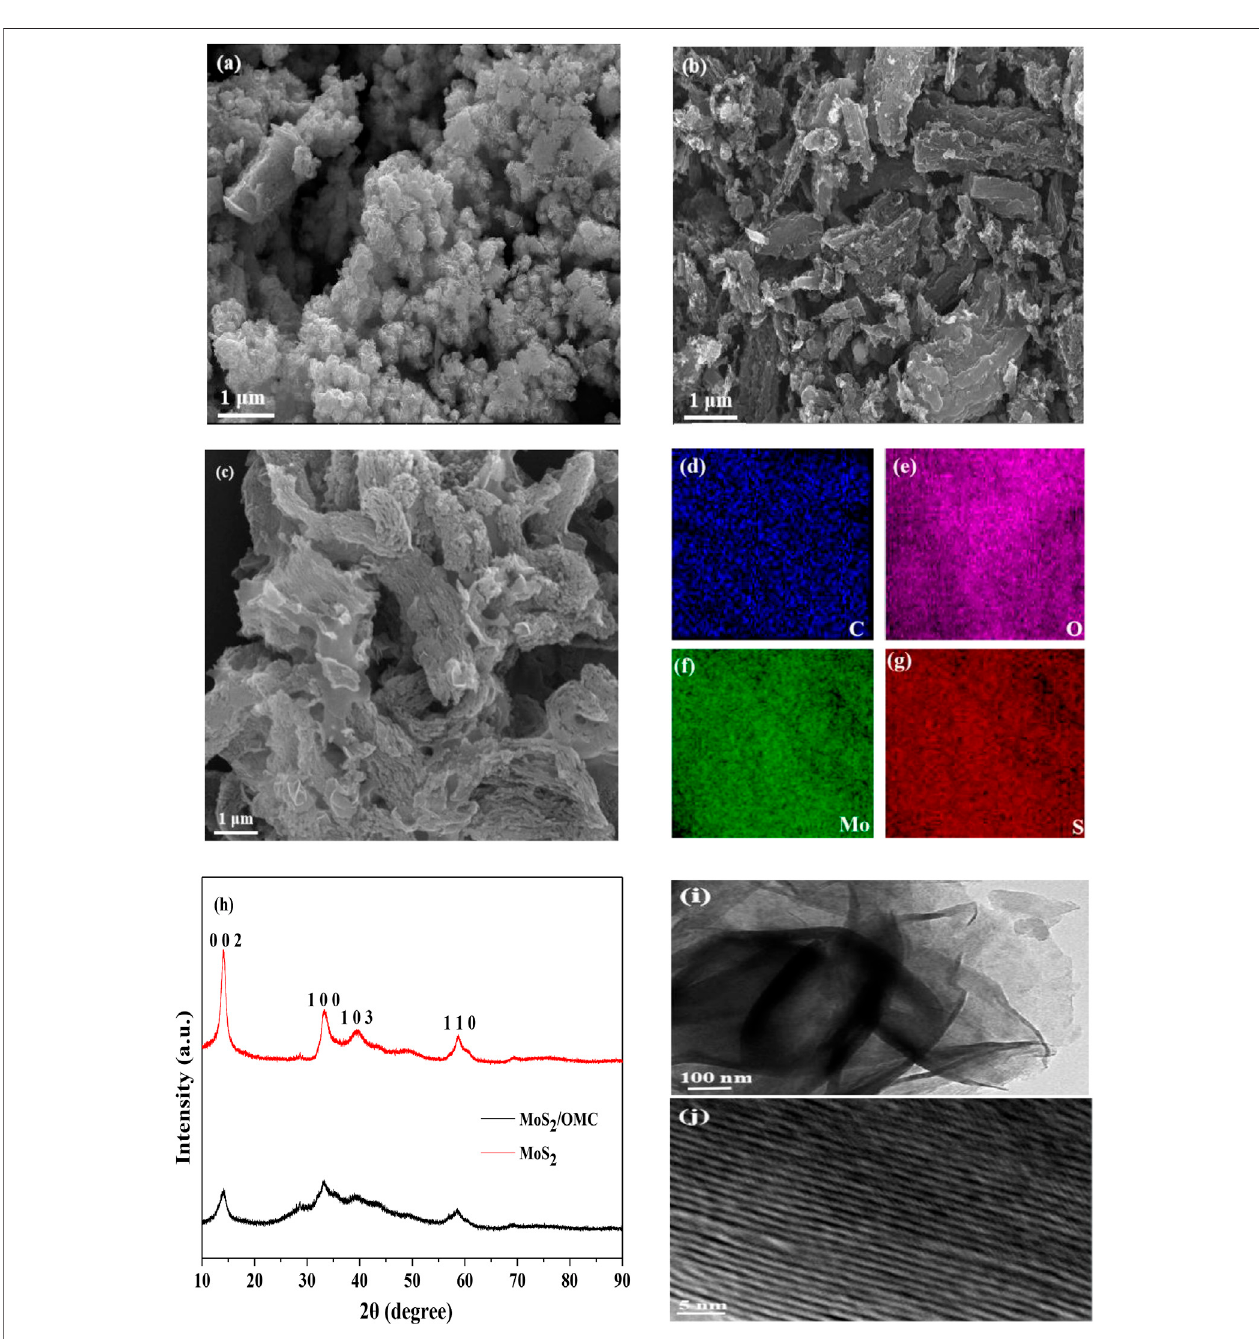
FIGURE1| SEManalysisofmaterials: (A) MoS 2 , (B) OMC,and (C) MoS 2 /OMCphotocatalysts;elementalmapsofMoS 2 /OMCcomposite: (D) carbon, (E) oxygen, (F) molybdenum, (G) sulfur, (H) XRD analysis of MoS 2 and MoS 2 /OMC, (I) TEM image of MoS 2 /OMC photocatalysts, and (J) HRTEM image of MoS 2 /OMC